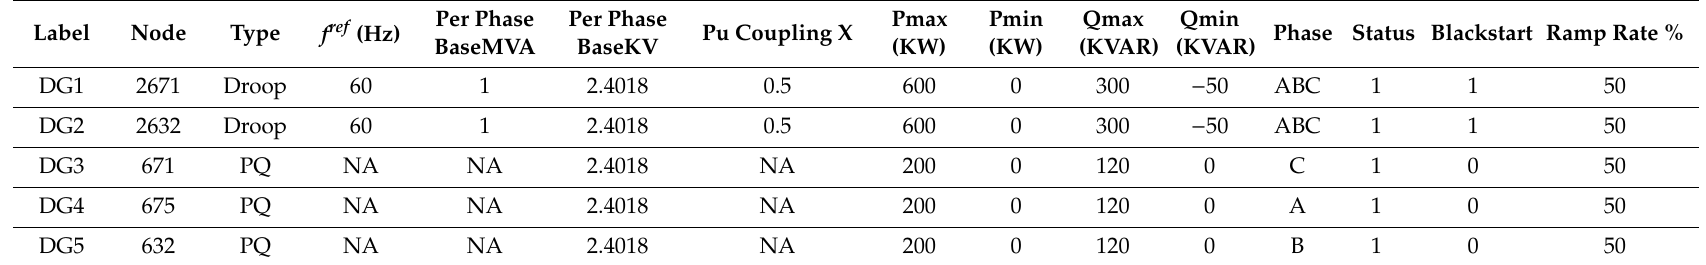
Table 2. DGs’ information for the test